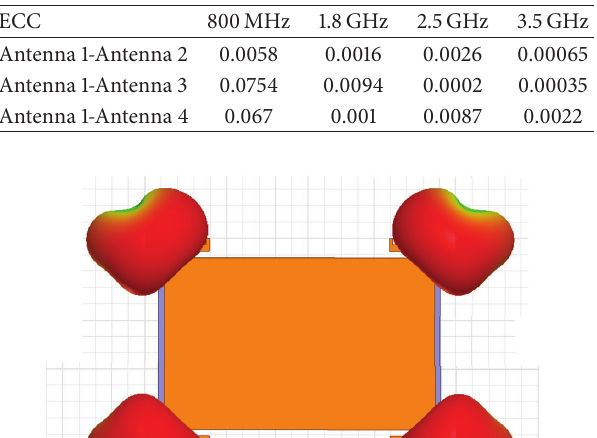
Figure 12: Measured 𝑆 -parameters of the realized prototype.